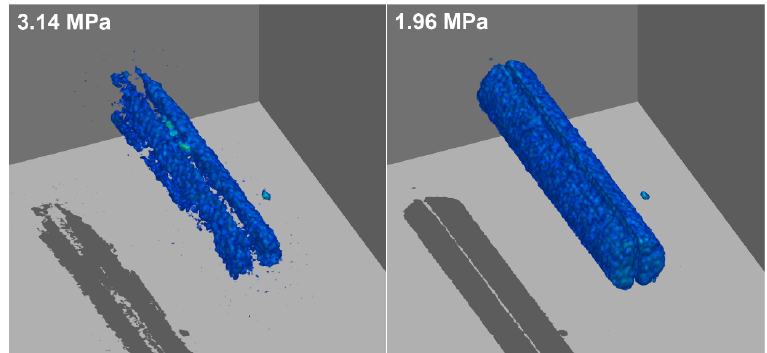
Figure 10. Depressurization sequence for sample c4. The initial water distribution was relatively heterogeneous, which resulted in areas with higher S h,CH4 . These areas require longer soaking time, as diffusion through hydrate layers is a slow process. Six pressure steps were required for full decomposition of the multi-compositional hydrate.